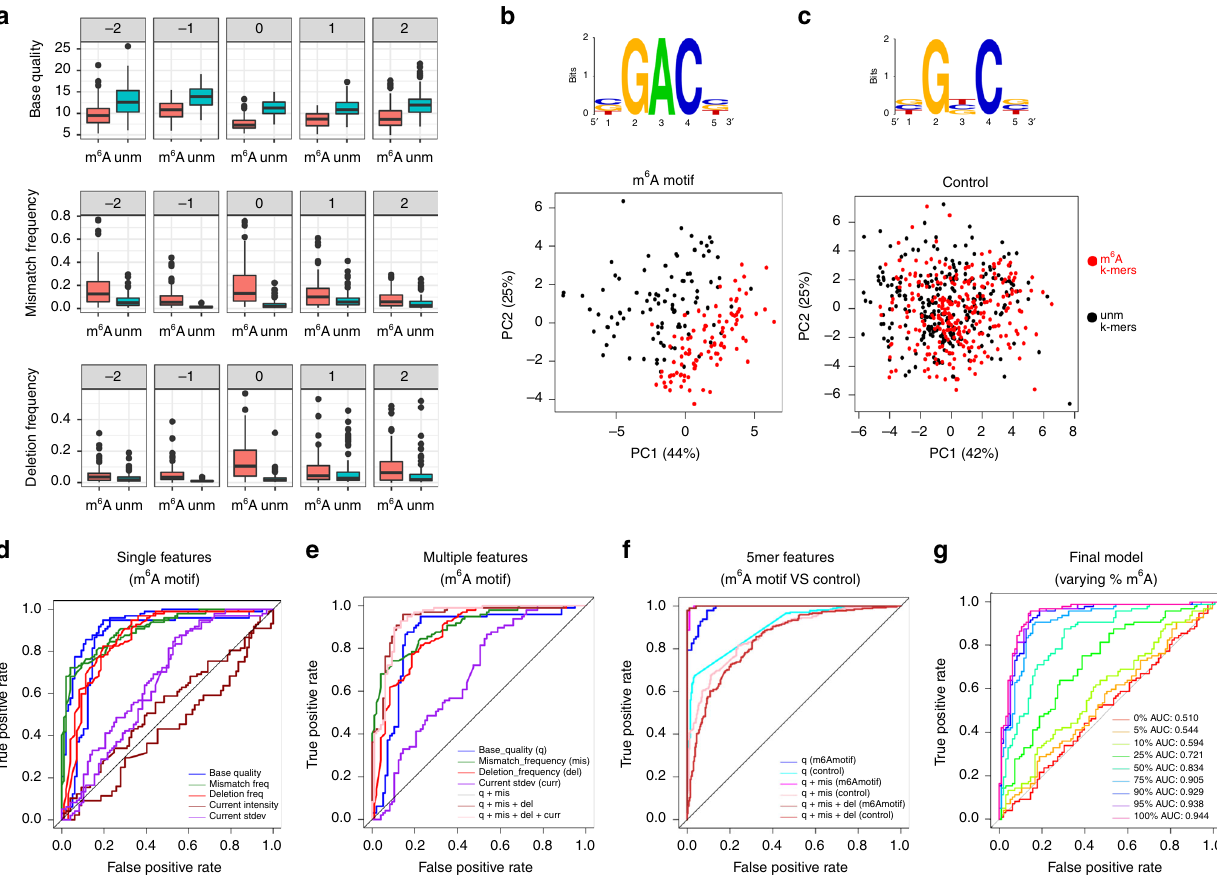
Fig. 2 Base-calling “ errors ” alone can accurately identify m 6 A RNA modi fi cations. a Base-called features (base quality, insertion frequency, and deletion frequency) of m 6 A motif 5-mers, and for each position of the 5-mer, are shown. The features of the m 6 A-modi fi ed transcripts ( “ m 6 A ” ) are shown in red, whereas the features of the unmodi fi ed transcripts ( “ unm ” ) are shown in blue. b , c Principal component analysis (PCA) scores plot of the two fi rst principal components, using 15 features (base quality, mismatch frequency, deletion frequency, for each of the fi ve positions of the k-mer) as input. The logos of the k-mers used in the m 6 A-motif RRACH set (left) and control set (right) are also shown. Each dot represents a speci fi c k-mer in the synthetic sequence, and has been colored depending on whether the k-mer belongs to the m 6 A-modi fi ed transcripts (red) or the unmodi fi ed transcripts (black). The contribution of each principal component is shown in each axis. ROC curves of the SVM predictions using: (i) each individual feature separately to train and test each model, at m 6 A sites ( d ); (ii) combined features at m 6 A sites, relative to the individual features ( e ); (iii) combined features at m 6 A sites relative to control sites, where the base-called “ errors ” information of neighboring nucleotides has been included in the model ( f ); and (iv) different mixtures of methylated and unmethylated reads, using the combined features model ( g ). Error bars indicate s.d. Source data are provided in the Source Data fi